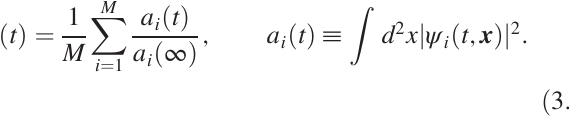
FIG. 2. Left: The freeze-out time t t as a function of τ expressed in units of T Q eq → const, as expected. For slow quenches, both quenches, t eq t and t are consistent with the τ 1 = 2 freeze eq exhibits logarithmic correction to the τ 1 = 2 the prediction of